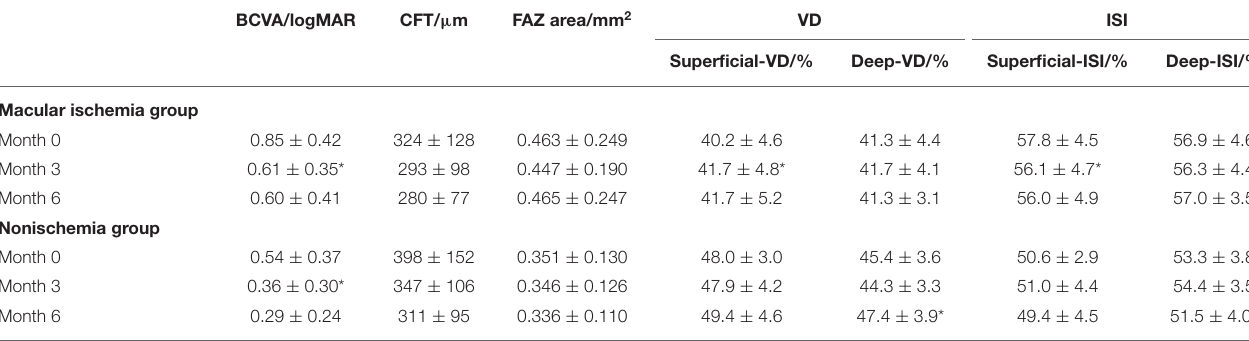
TABLE 2 | Changes in the BCVA, CFT, FAZ area, VD, and macular ISI between the macular ischemia group and the nonischemia group.